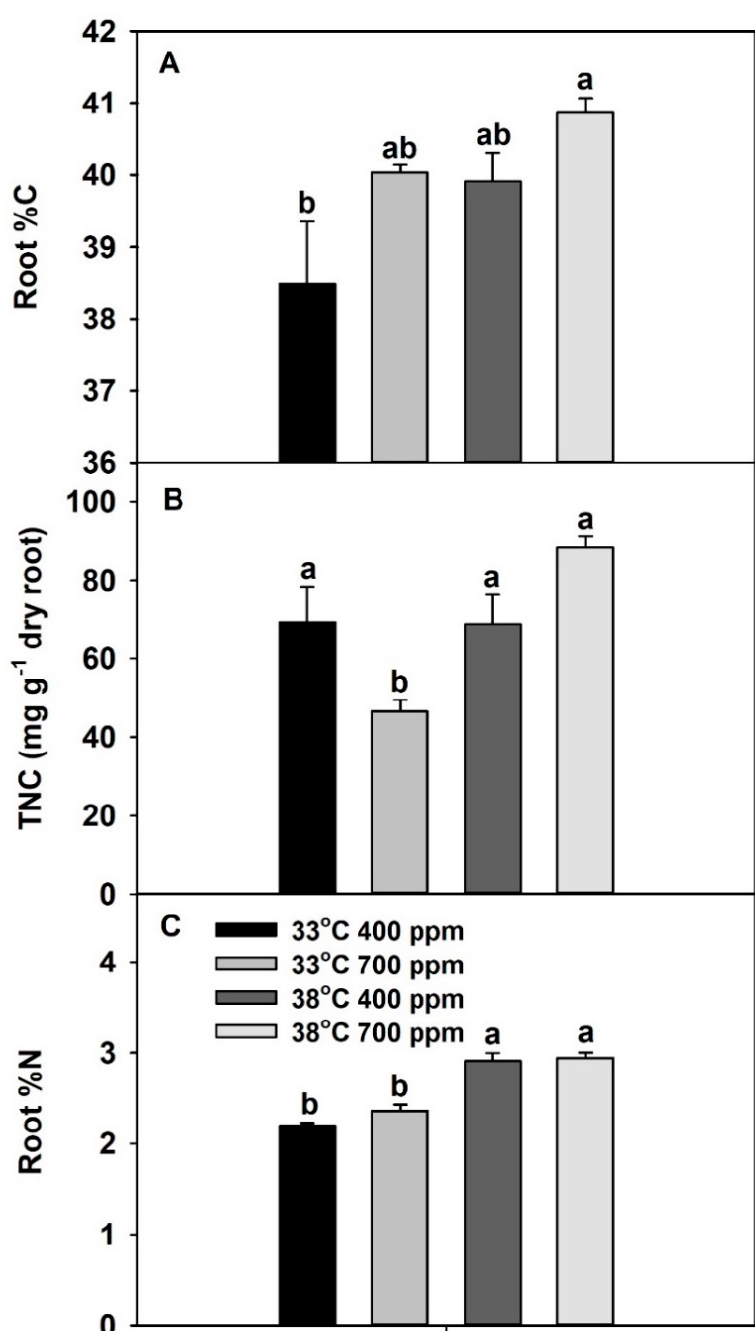
Figure 5. Effects of ambient (400 ppm) vs. elevated (700 ppm) CO 2 and near-optimal (33 ◦ C) vs. chronic warming (38 ◦ C) day-time temperatures on ( A ) root %C, ( B ) total nonstructural carbohydrates (mg g − 1 dry root mass), and ( C ) root %N of Solanum lycopersicum , grown for 21 days. Each bar represents mean ( n = 5) + 1 SEM. Within each panel, bars not sharing the same letters are significantly different ( p < 0.05, Tukey’s test).